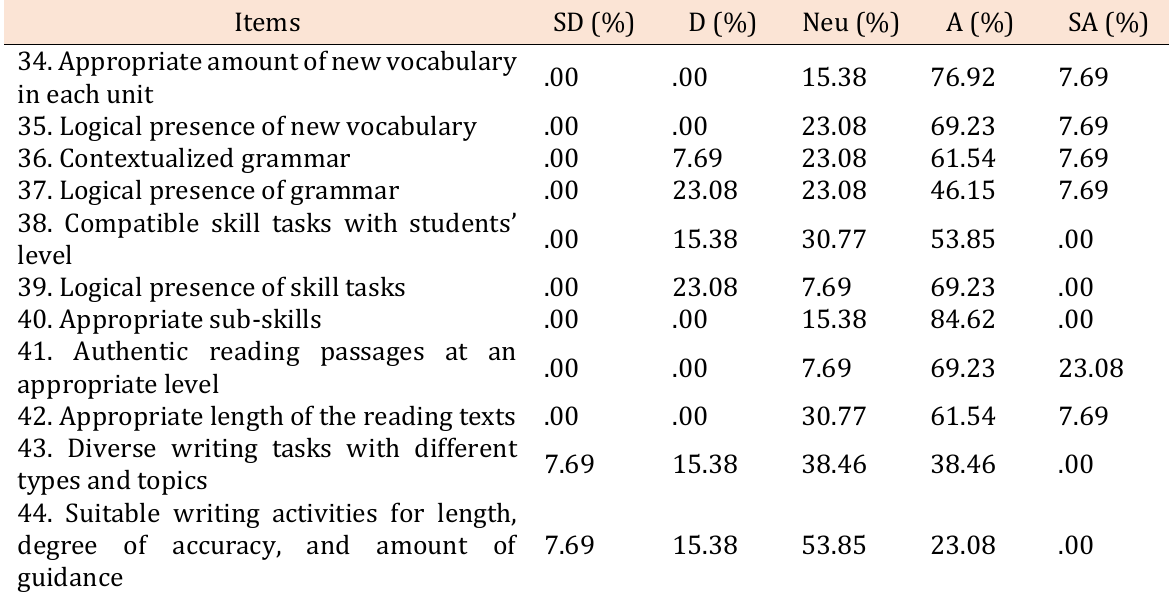
Table 6. EFL teachers’ evaluation of Language Type and